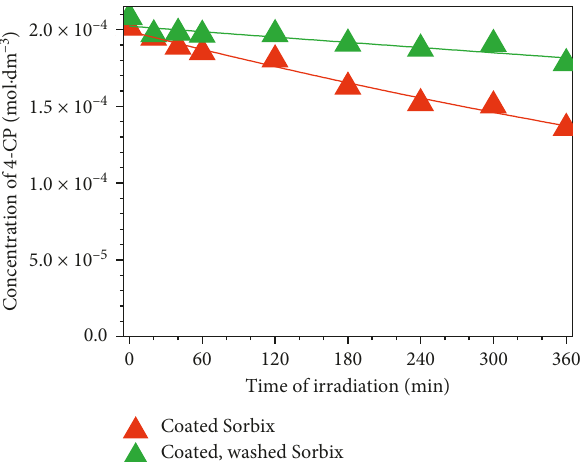
Figure 4: Photocatalytic degradation of 4-CP (in laboratory photoreactor at a stirring rate of 500rpm) using coated Sorbix and coated, washed